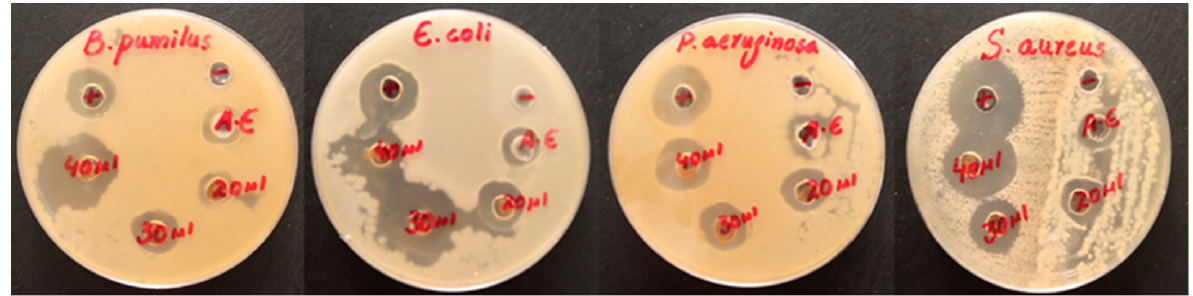
Figure 6. Antibacterial activity of algal-based Fe 3 O 4 NPs against gram-positive and gram-negative bacteria.